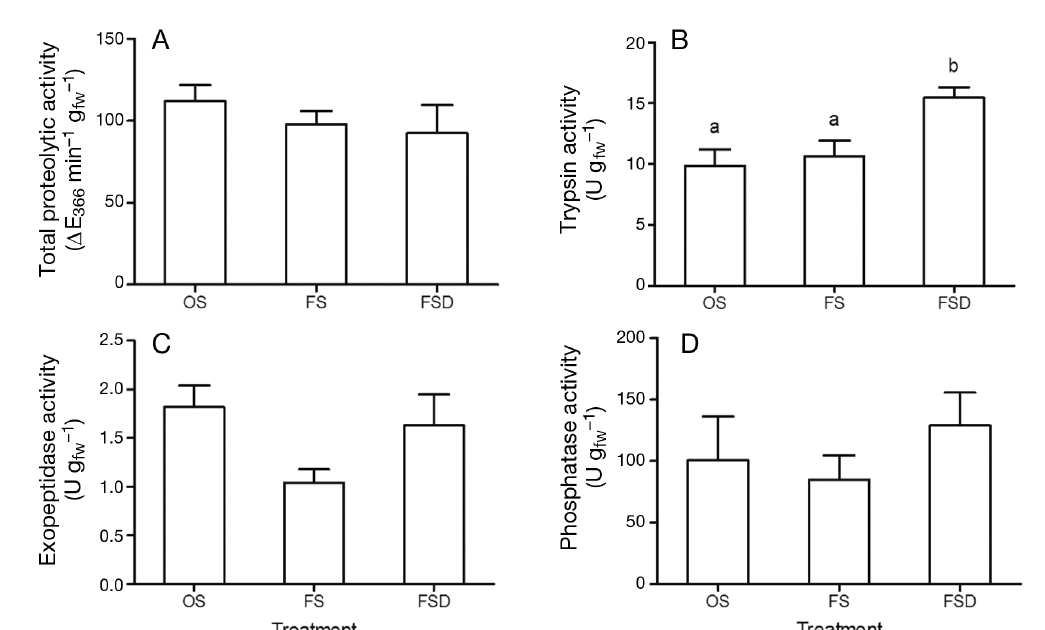
Fig. 4. Specific activities of (A) total proteolytic activity, (B) trypsin, (C) leucine aminopeptidase and (D) alkaline phosphatase; fw: fresh weight. Data are means + SEM (n = 8). Different letters above columns indicate significant differences (p ≤